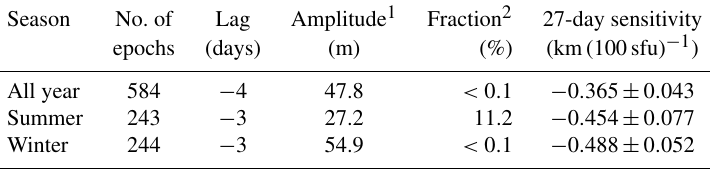
Table 2. Overview of the results for different seasons.